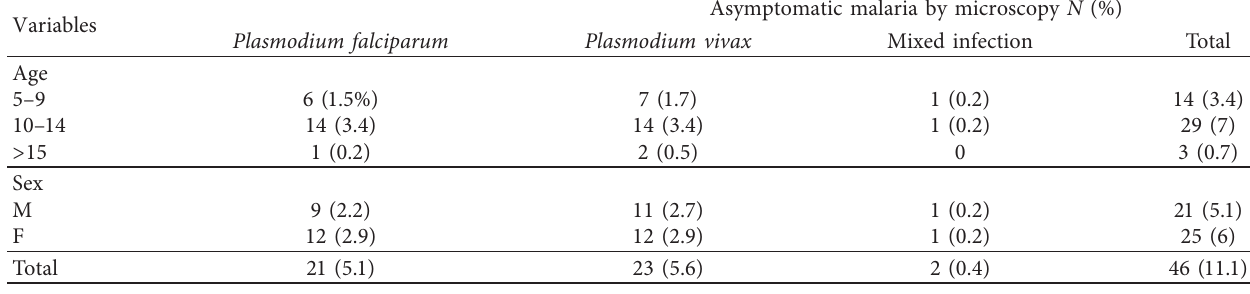
Asymptomatic malaria by microscopy N (%)